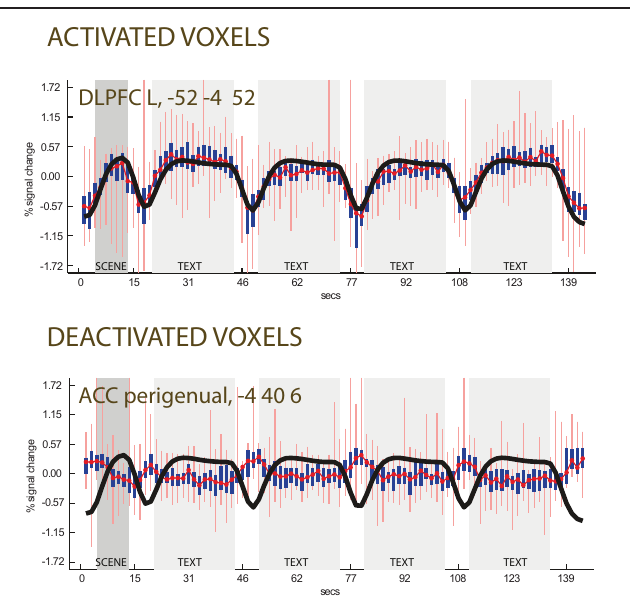
FIGURE 4 | Time-course plots in selected voxels (centered data). Top row: activated voxels in the left DLPFC and VLPFC. Bottom row: deactivated voxels selected from the regression of the individual differences in the use of emotional terms, showing relative activation during fixation. The black line is the regressor obtained by convolving the task with a canonical BOLD curve, which tracks activation due to